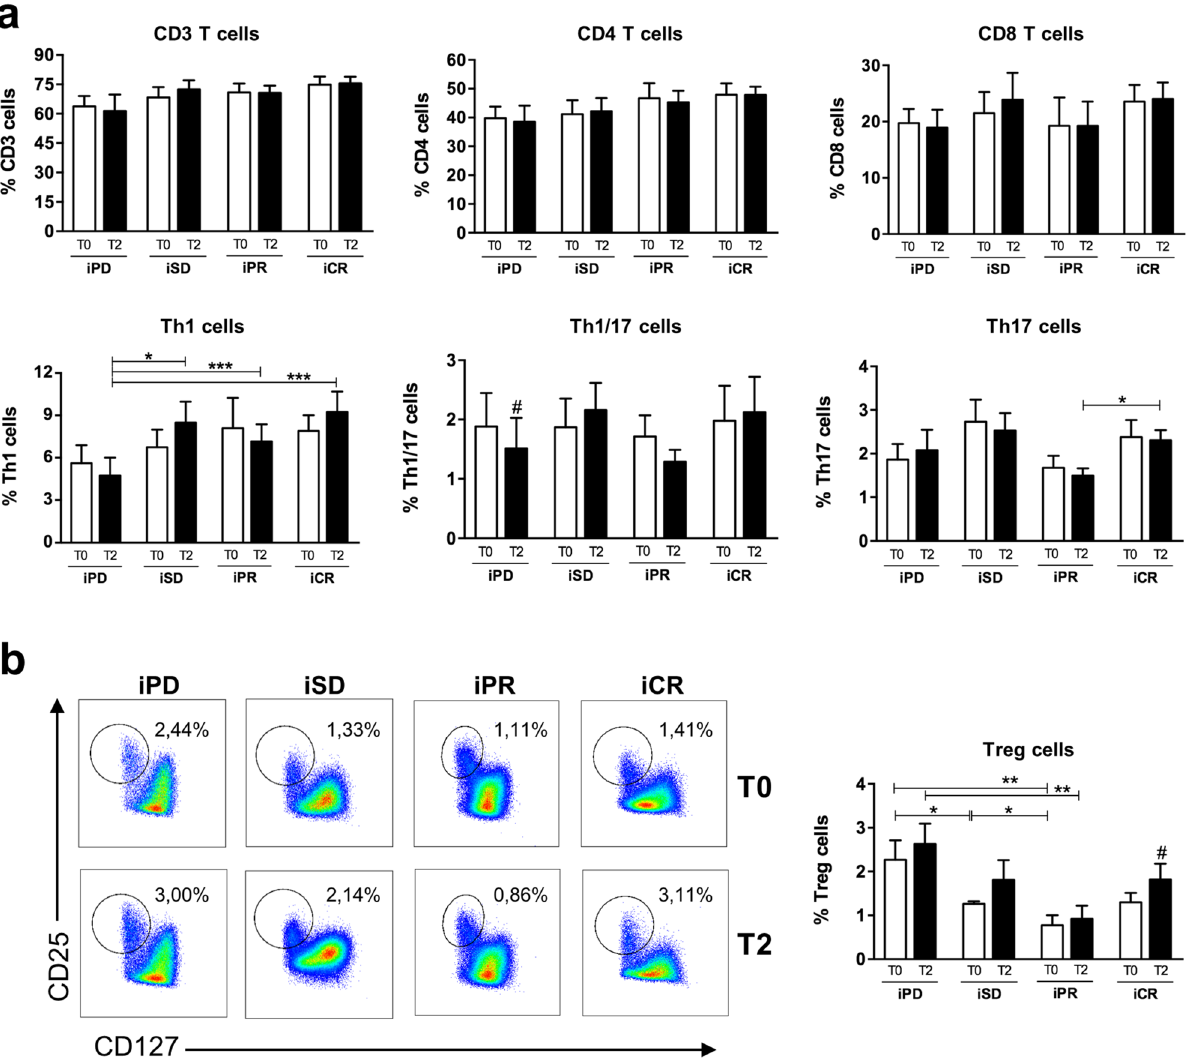
Figure 3. Frequency of circulating T lymphocytes in melanoma patients treated with CPIs. Frequency of circulating T lymphocytes, including ( a ) CD3, CD4, CD8, Th1, Th1/17, Th17 cells, and ( b ) Treg cells, were analyzed by flow cytometry in PBMCs of melanoma patients before (T0) and after 3 months (T2) of treatment. Representative flow cytometry plots of Treg frequency for each condition are reported in Panel ( b ). Best overall response according to iRECIST criteria: iPD, progressive disease (n. 7 patients); iSD, stable disease (n. 8 patients); iPR, partial response (n. 8 patients); complete response, iCR (n. 10 patients). Frequency data of each T cell population was calculated as percentage on total alive lymphocytes cells. Data are indicated as mean value ± standard error of the mean (SEM). * p < 0.05, ** p < 0.01, *** p < 0.001 as assessed by Mann–Whitney U test to compare between-group differences; # p < 0.05 by Wilcoxon signed-rank test to evaluate before–after treatment